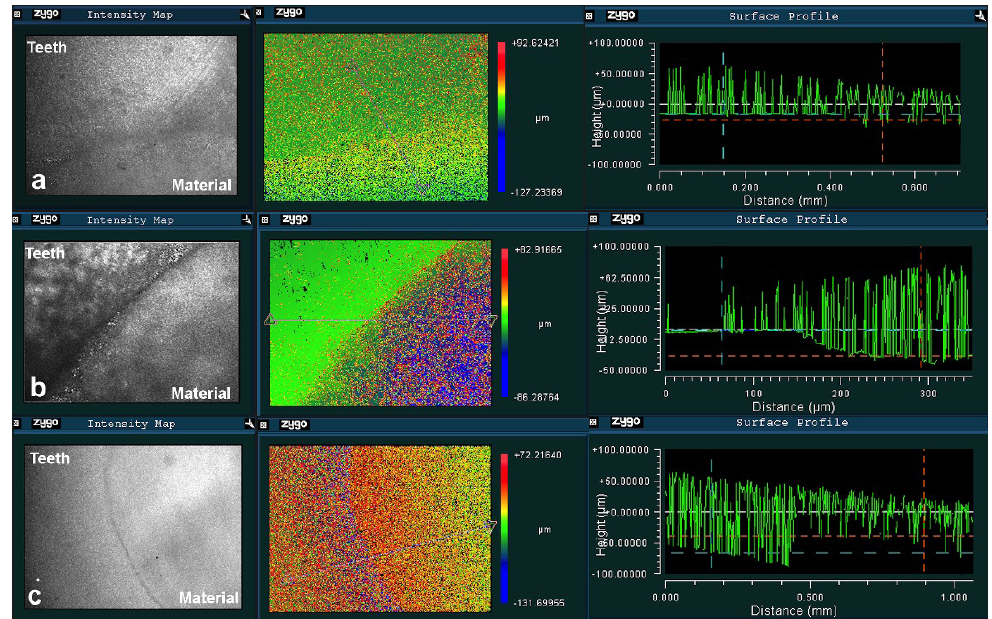
Figure 1- Representative 3D images for the measurement of height differences between the tooth surface and the material surface showing (a) constant, (b) decreased (shrinkage), and (c) increased (expansion) surface level of materials relative to the tooth surface